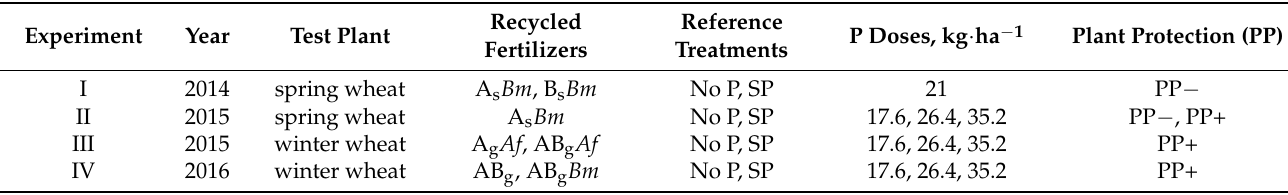
Table 4. Field experiments conducted.